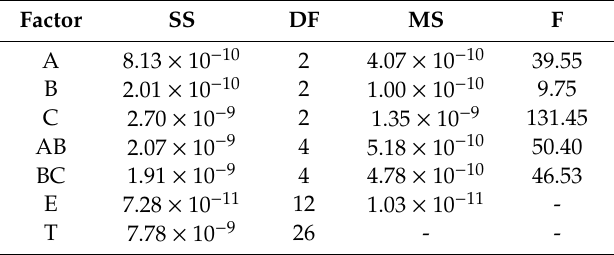
Table 6. ANOVA results after pooling the A × C factor with an F value less than 1 into the error term.